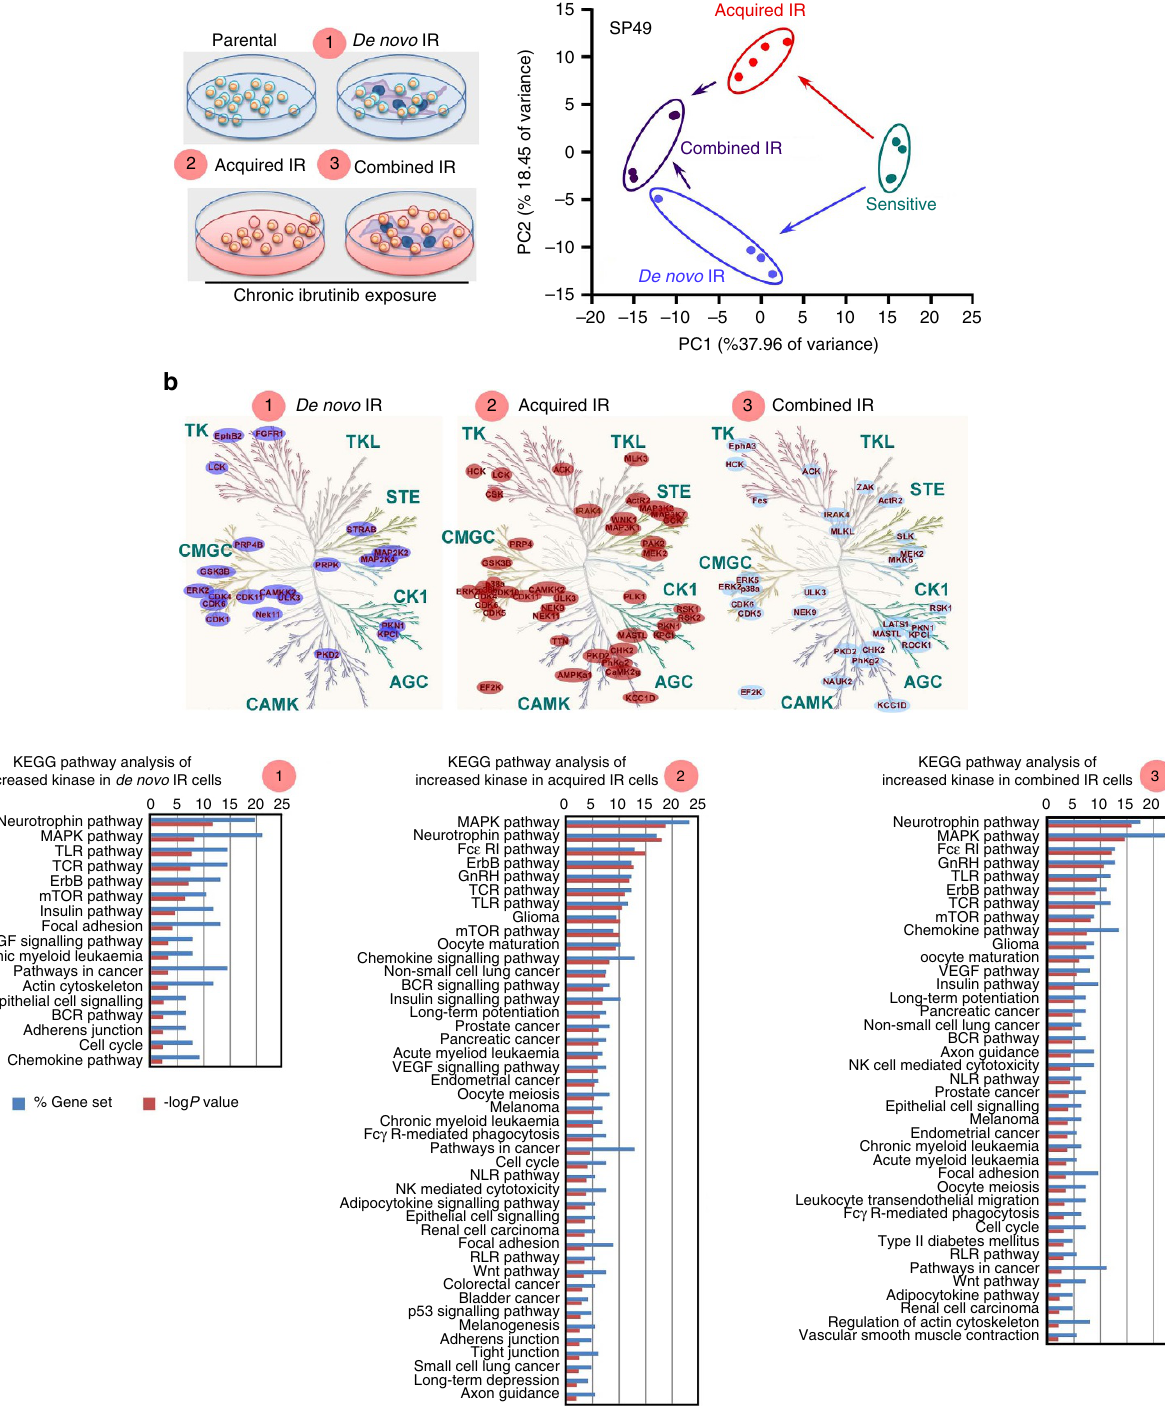
Figure 5 | Functional coordination between TME-mediated ( de novo ) and acquired IR. ( a ) Diagram of three types of drug resistance mechanisms for kinase activity profile: A parental cells after co-culture with stromal (HK) cells ( de novo DR), B IR cells after chronic ibrutinib exposure in cell suspension (acquired DR) and C IR cells selected with drug (chronic ibrutinib exposure) in the presence of stroma (combined DR). Parental cells in suspension are as reference. ( b ) Significant increased kinase ATP-binding changes in de novo DR cells (left), acquired DR cells (middle) and combined DR (right). Parental cells maintained in suspension were used as the control reference population (Jeko-1, HBL-2 and SP49). Kinome trees reproduced courtesy of Cell Signaling Technology. ( c ) Principal component analysis (PCA) of kinomes of parental/sensitive, de novo IR (TME-mediated), acquired IR and IR selected while adherent to TME stroma (combined IR) cells, which correlate with the first two principal components. ( d ) KEGG pathway enrichment analysis revealed highly significant pathways ( (cid:2) log P value 4 2) in the three types of IR kinome. Parental cells maintained in suspension were used as the control reference population. There is a greater overlap between acquired IR and combined IR relative to de novo IR. See also Supplementary Fig.